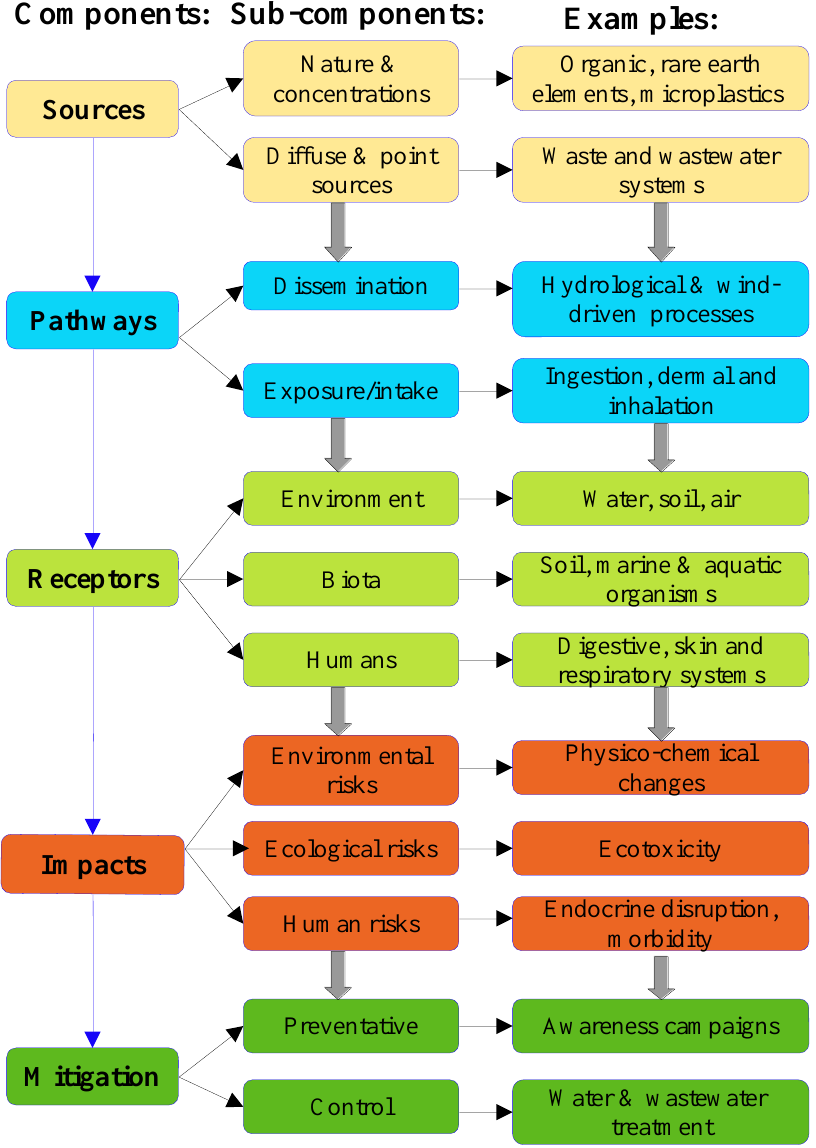
Figure 1. A summary depiction of the Source–Pathway–Receptor–Impact–Mitigation (SPRIM) con- tinuum framework.